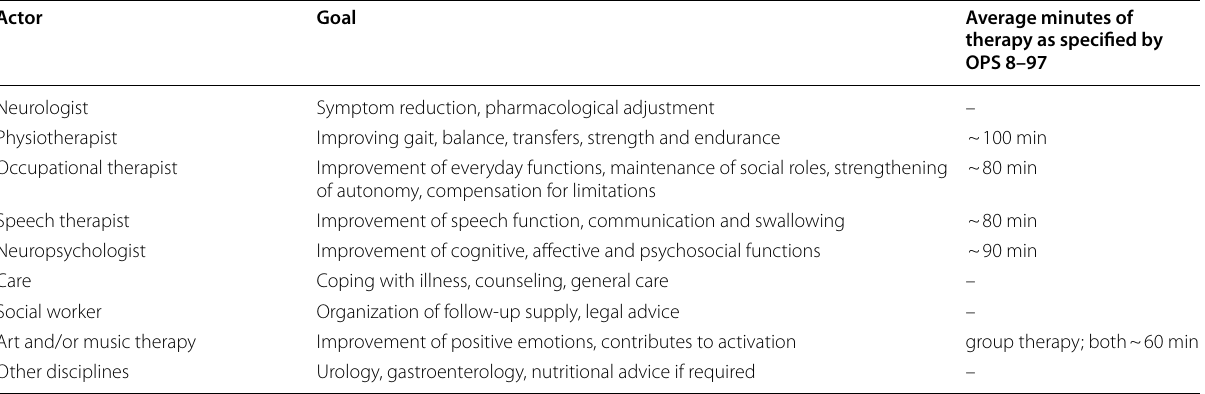
Table 1 Actors and goals of Parkinson’s complex therapy (PKB)